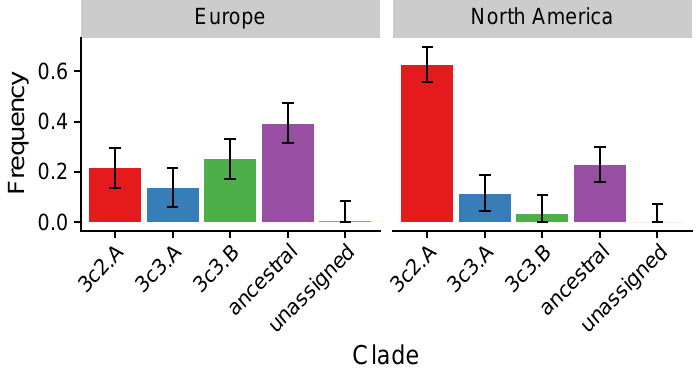
Figure A16. Frequencies of H3N2 clades circulating during the 2014–2015 season, stratified by region. Error bars indicate 95% multinomial confidence intervals. Notably, 3c2.A strains are significantly more frequent in North America compared to Europe, and 3c3.B strains are significantly less frequent in North America compared to